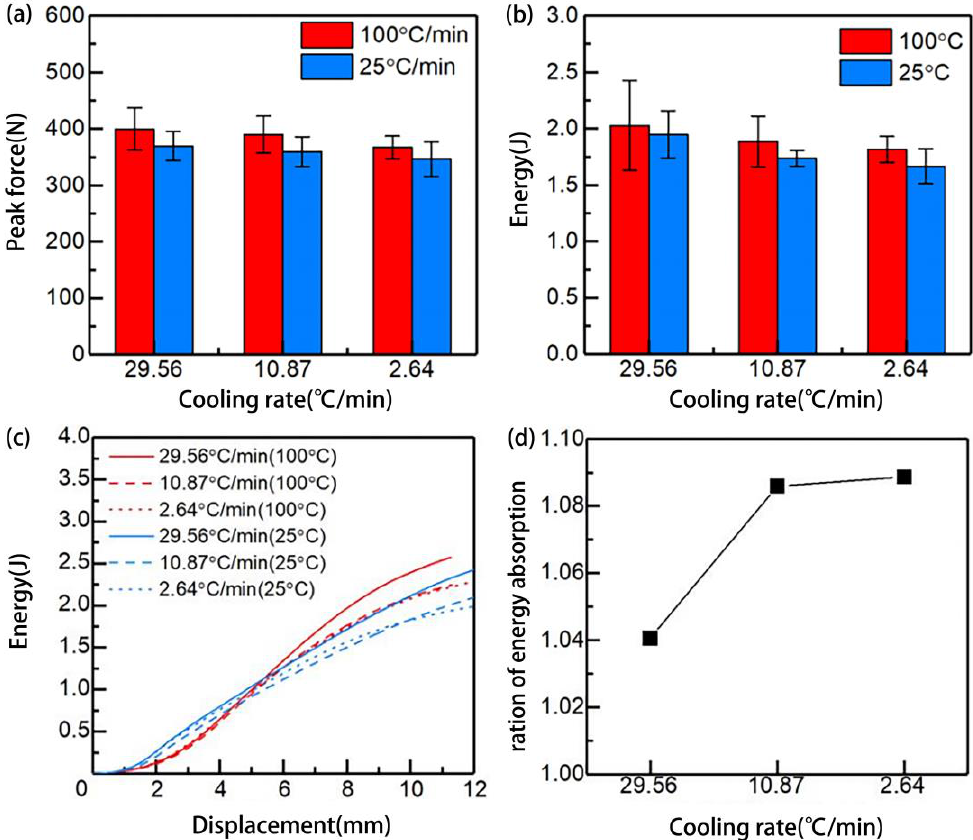
Figure 11. The results of laminates manufactured at different cooling rates carried out by the QSI test under 25 °C and 100 °C: ( a ) peak force when failure occurred; ( b ) total energy absorbed by the sample; ( c ) energy curve; ( d ) ratio of energy absorption.